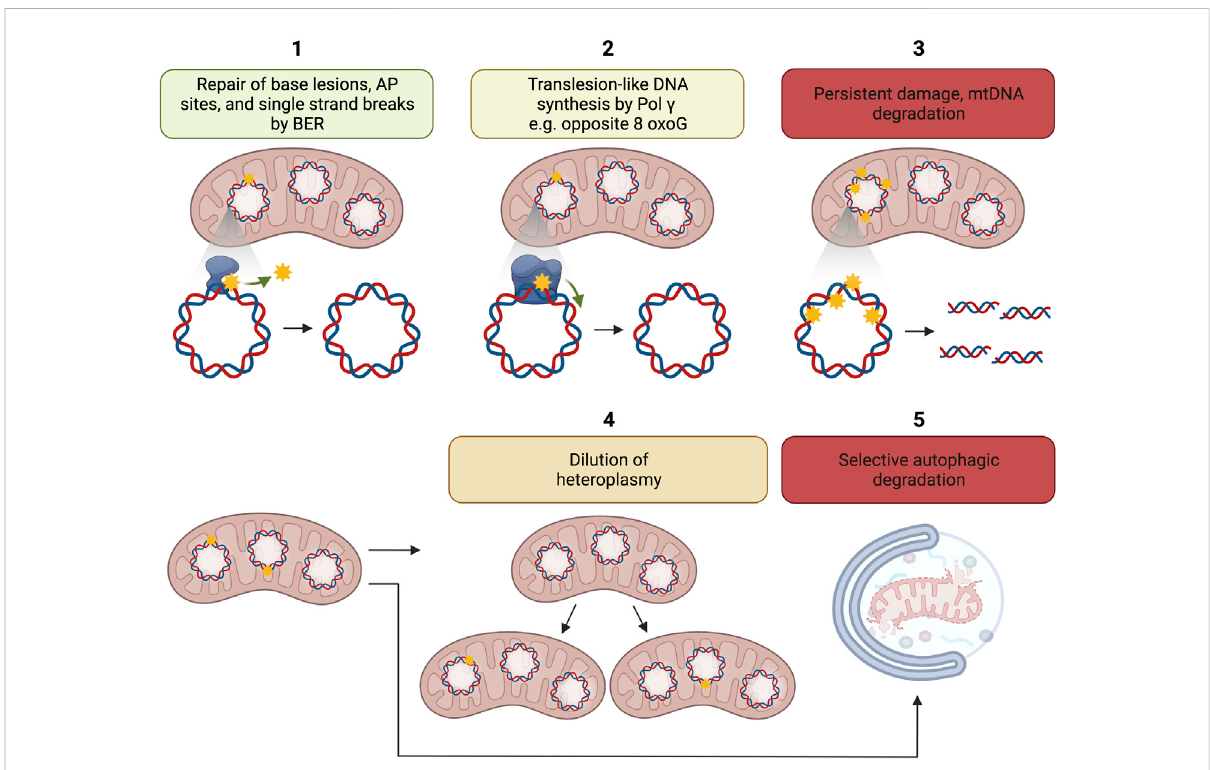
FIGURE 2 Putative mechanisms for disconnection between mtDNA damage and mtDNA mutation load. 1. Repair of base lesions, AP sites, and single strandbreaksbyBER;2.TranslesionlikeDNAsynthesisbyPol γ e.g.,opposite8-oxoG;3.Persistentdamagemayleadtothedegradationofdamaged mtDNA; 4. Dilution of heteroplasmy, i.e., ratio of mutant to wild-type mtDNA by mitochondrial dynamics; 5. Possible selective autophagic degradation of mitochondria with high levels of mtDNA damage. The fi gure has been generated using Biorender.